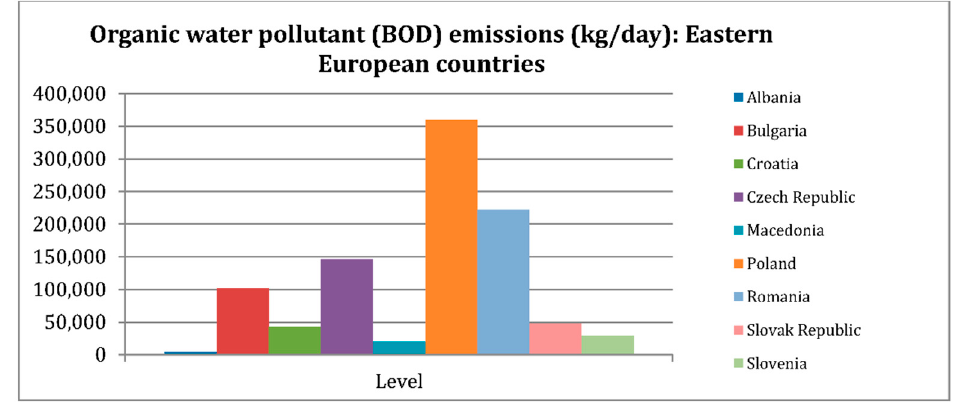
Figure 1. Water pollution caused by the textile industry of G20 countries, from a world database in 2007 (adapted with permission from [3], Copyright 2022, MDPI).